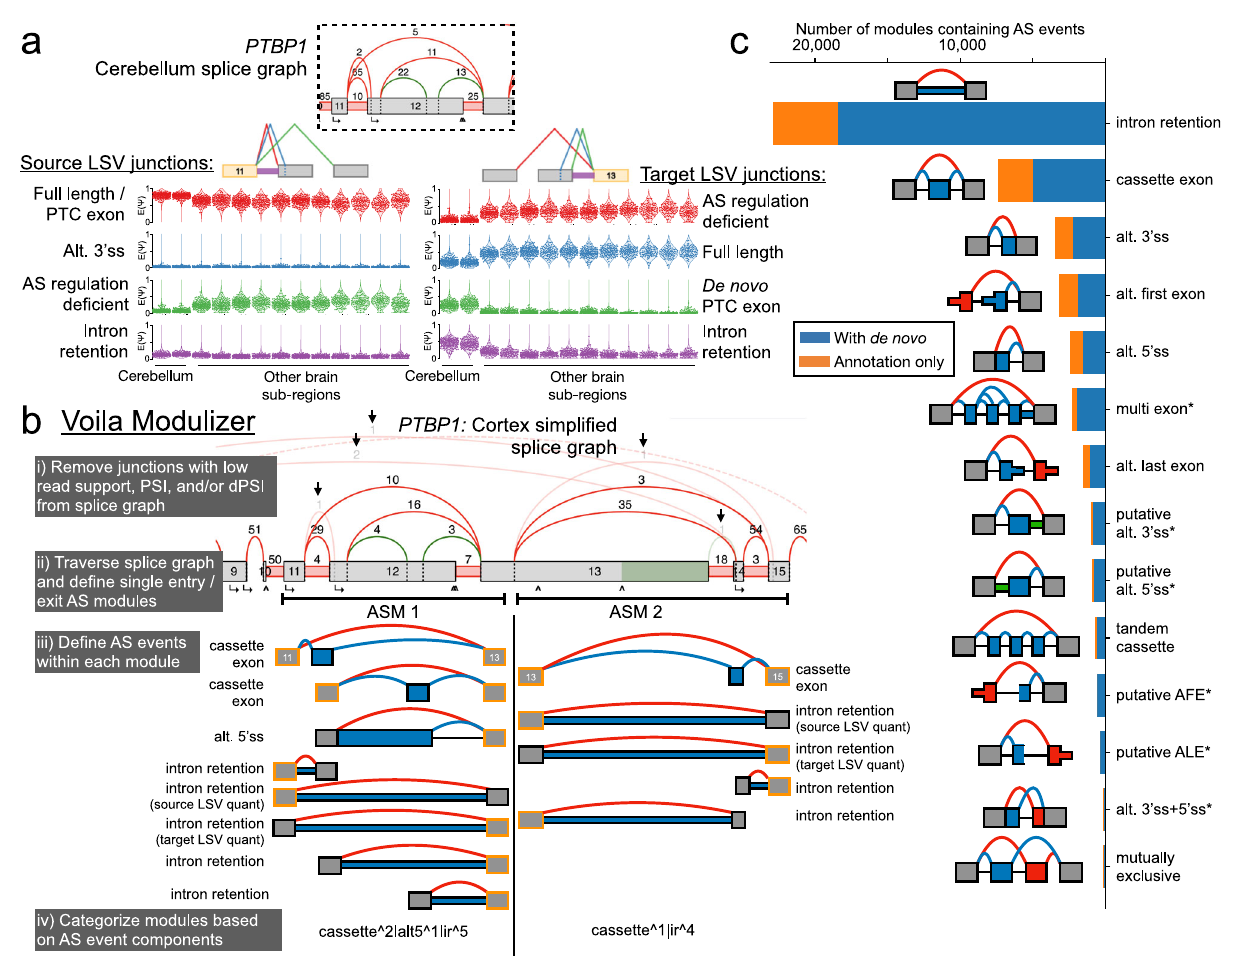
Fig. 4 | Downstream analysis of alternative splicing modules with VOILA v2. a Top shows region of human PTBP1 splicegraph (with reads from combined cer- ebellum samples) and two LSVs corresponding to a mammalian speci fi c exon skipping event that alters PTBP1 splicing regulatory activity 17 (green junction in exon 11 source LSV, left; red junction in exon 13 target LSV, right) and de novo detectionofaconserved,PTC-containingexonpreviouslyshowntobeincludedin mouse neuronal tissues 3 (green junction in exon 13 target LSV). Bottom shows distribution of PSI across the 13 brain tissue groups as well as annotation of each junction. b VOILA Modulizer work fl ow (gray boxes) and an example region of the more in any of the 13 brain tissue groups were removed (arrows). Two alternative splicing modules (ASMs) were de fi ned as single entry, single exit regions of the splicegraph and within these modules binary, AS events are de fi ned. Gray exons